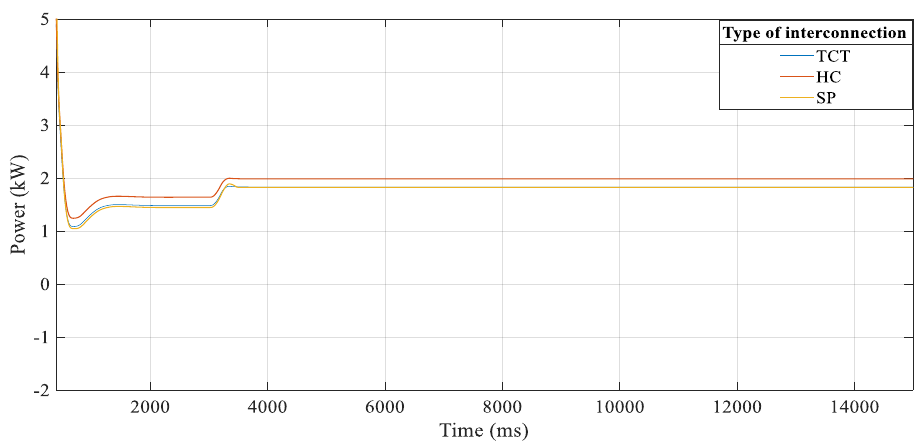
Energies 2019 Figure 25. Impact of multiple faults ‘F4′ on power grid (monocrystalline PV). Figure 25. Impact of multiple faults ‘F4 (cid:48) on power grid (monocrystalline PV).